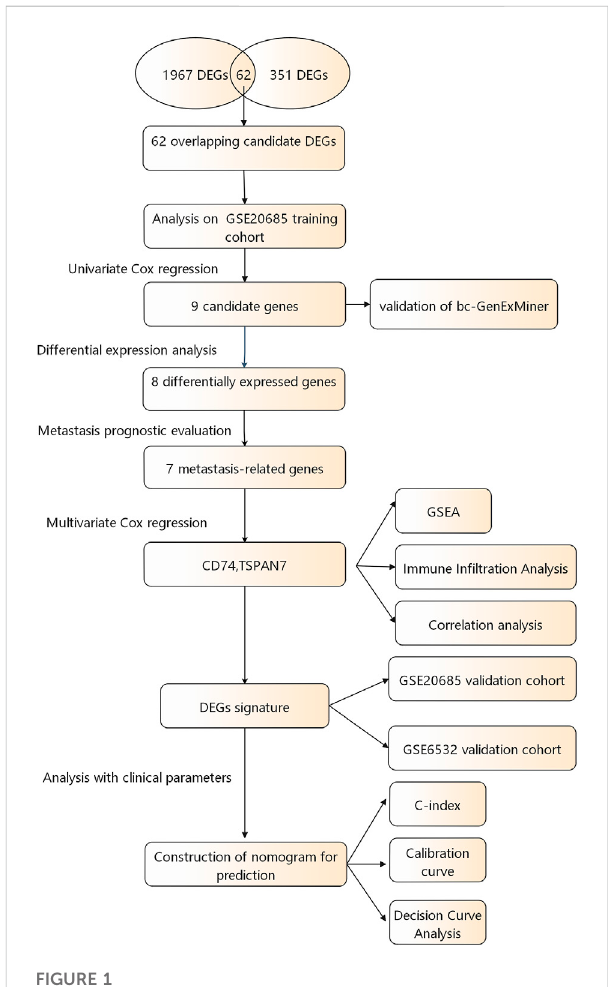
FIGURE 1 A fl owchart of the study